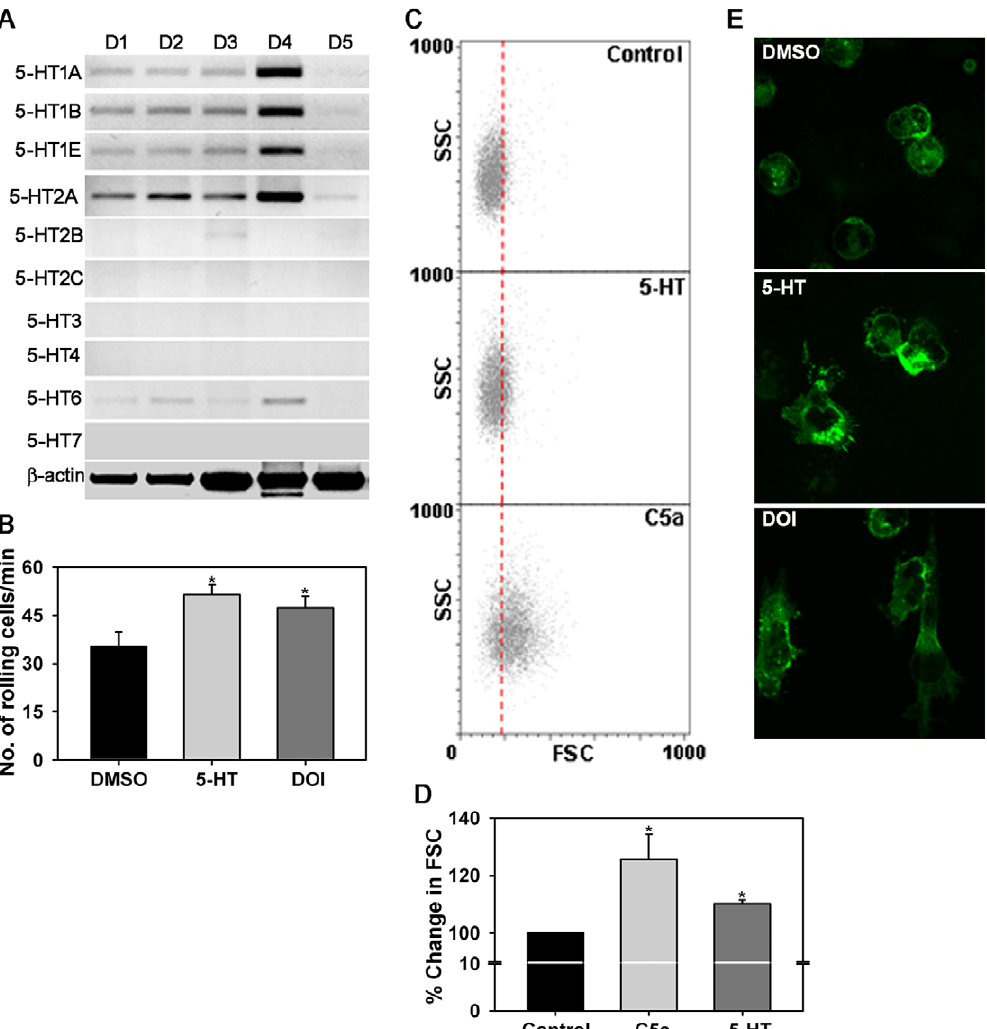
Figure 1. 5-HT induces rolling of human Eos and alters cell shape and morphology. ( A ) Expression of 5-HT receptors by human Eos from allergic donors (D1-D5) by RT-PCR. Expression of b -actin is shown as the internal control. ( B ) Rolling of human Eos on rh VCAM-1-coated cover-slips under conditions of flow in vitro . Cells were treated with 5-HT or the 5-HT2A/2C receptor agonist DOI (both at 10 m M) for 5 min prior to infusion into the flow chamber. Cells treated with DMSO (vehicle) alone served as a control. ( C ) FSC versus side scatter (SSC) dot plots for untreated (control) and 5- HT (10 m M)- or C5a (1 nM, positive control)-treated human Eos after 1 min by GAFS assay. ( D ) Human Eos shape change measured as an increase in FSC after treatment with 5-HT or C5a for 10 min at 37 u C measured. Results are expressed as percent change in mean FSC of stimulated cells compared to control cells. ( E ) Confocal microscopy of FITC-phalloidin stained human Eos initially allowed to attach to rh VCAM-1 on cover-slips for 20 min in PBS followed by an additional 5 min in the presence of 5-HT or DOI (both at 10 m M) or vehicle. Magnification 6 600. Combined data (Mean 6 SEM) of Eos from 4–6 donors is shown for B and D. *p , 0.01 for 5-HT and , 0.03 for DOI in B for comparison with DMSO-treated Eos and , 0.01 in D for comparison with control Eos. Representative data of six independent experiments in C and three independent experiments in E with Eos from different donors is shown. doi:10.1371/journal.pone.0054840.g001 right panel) since inhibitors/antagonists of these molecules inhibited PI3K (Fig. 5, A), PKC and calmodulin (Fig. 5, B) but not of G a i rolling to near or below background levels observed with vehicle- (Fig. 5, B). Quantitation of DOI-induced changes in morphology of treated cells. Blockade with PT which targets G a i proteins did not adherent BM-Eos and their significant inhibition by pretreatment alter DOI-induced Eos rolling (Fig. 4, C, right panel). In addition to with MDL-100970 as well as inhibitors of ROCK, MAPK, PI3K, inducing rolling, DOI induced distinct changes in morphology of PKC and calmodulin is shown in Fig. 5, C and D. These data BM-Eos adherent on VCAM-1 (Fig. 5, A). Several DOI-treated Eos demonstrate that the effect of DOI on rolling under conditions of exhibited spreading with formation of leading edges (Fig. 5, A, top flow correlates with its effect on cell morphology. Further, murine row, center panel) while vehicle-treated control cells largely Eos respond in a manner similar to AML14.3D10 cells when remained spherical with few cells spreading (Fig. 5, A, top row, left exposed to DOI. More importantly, together with the ability of 5- panel). Further, DOI-induced changes in murine BM-Eos mor- HT and DOI to alter the shape of non-adherent cells and induce phology were prevented when cells were pretreated with MDL- actin polymerization, respectively, the above findings suggest that 100907 to inhibit 5-HT2A or with inhibitors of ROCK, MAPK,